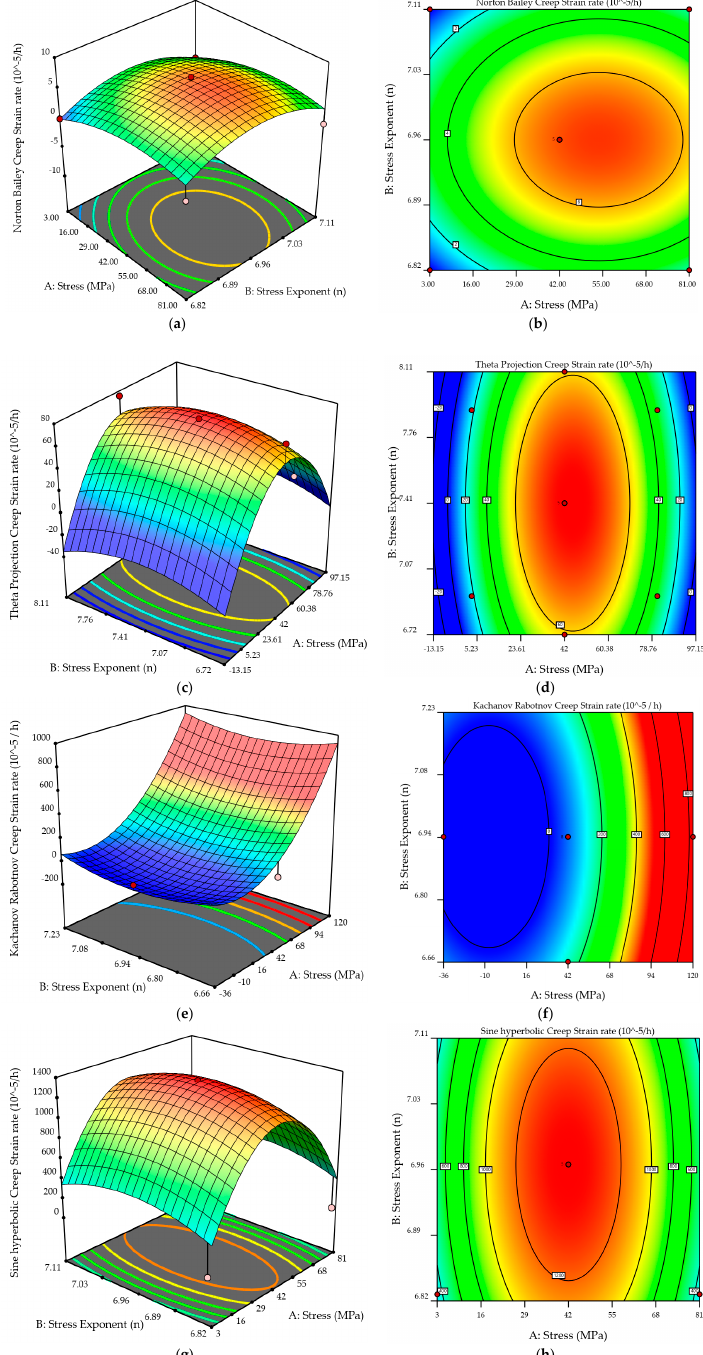
Figure 15. ( a ) The combined impact of design factors on the response NB model’s creep strain rate ( ε t ); ( b ) contour creep deformation map for NB model; ( c ) the combined impact of design factors on the response TP model’s creep strain rate ( ε t ); ( d ) contour creep deformation map for TP model; ( e ) the combined effect of design factors on the response KR model’s creep strain rate ( ε t ); ( f ) contour creep deformation map for KR model; ( g ) the combined effect of design factors on the response SH creep strain rate ( ε t ); ( h ) contour creep deformation map for SH